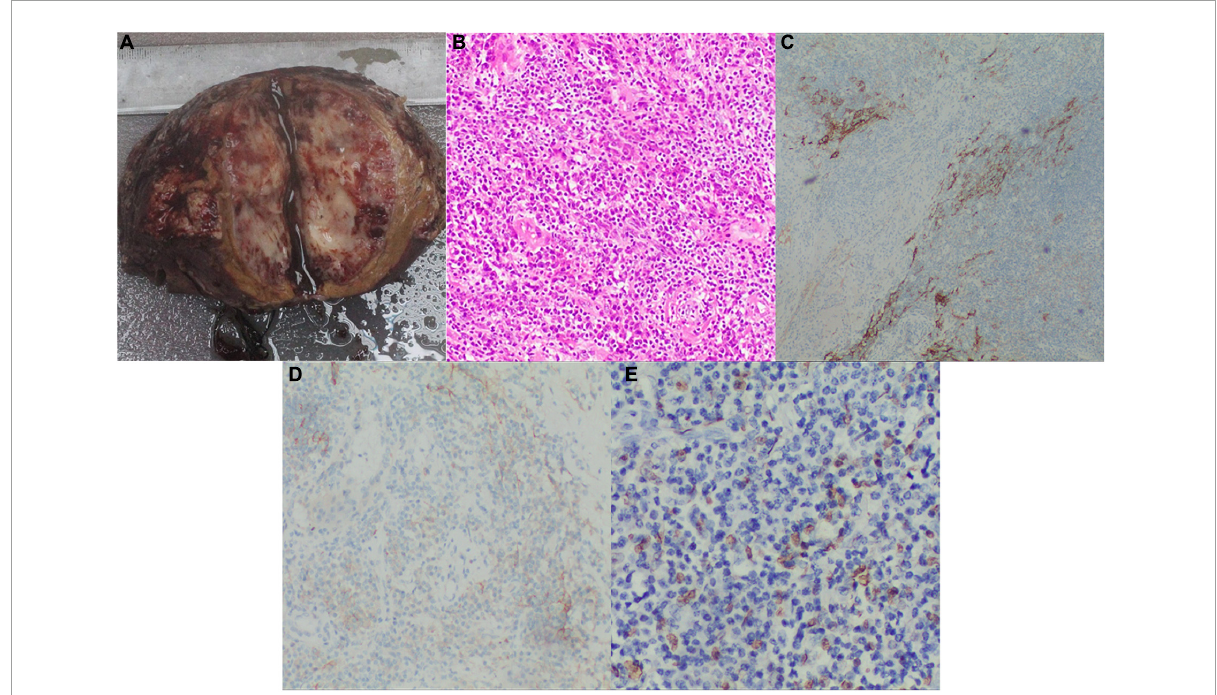
FIGURE2 Postoperative pathology examinations. (A) Grossly, the cut surface of the fleshy neoplasm with necrosis and hemorrhage (tumor size: 7.0 × 5.0 cm); (B) H&E stained image showing that the tumor tissue had a meshwork-like architecture with abundant vascular-like proliferation, magnification: 200X; (C) The positive IHC result of CD21, magnification: 100X; (D) The positive IHC result of CD35, magnification: 100X; (E) The positive result of EBV for in situ hybridization, magnification: 200X. H&E, hematoxylin and eosin; IHC, immunohistochemical; EBV, Epstein Barr